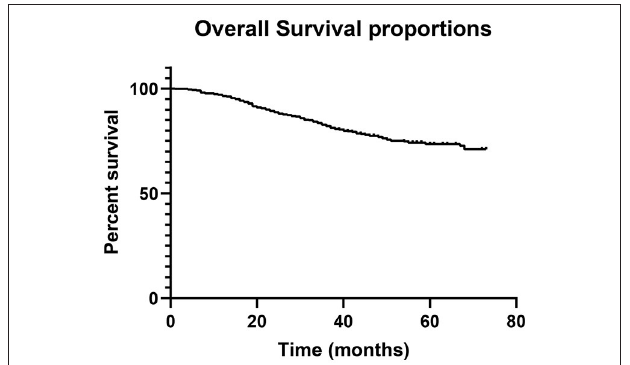
FIGURE 1 | Overall survival of the entire